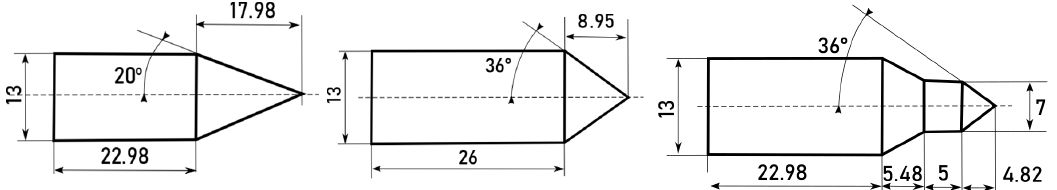
Figure 3. Geometry of the considered projectiles (dimensions in mm).